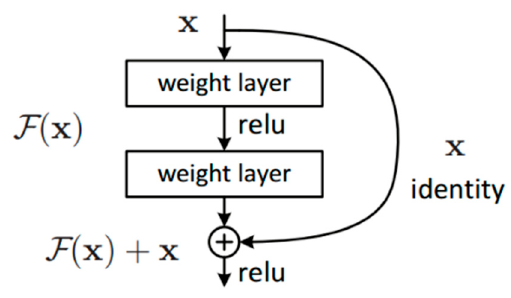
Figure 4. Visualization of the residual block of the residual network (ResNet).